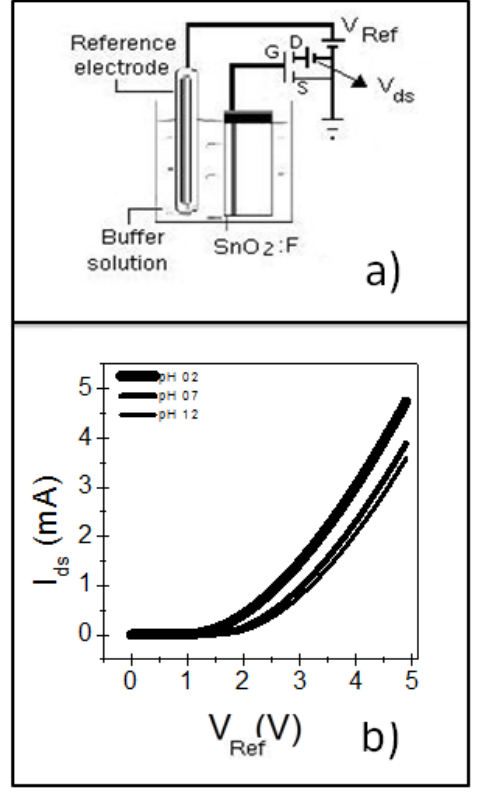
Fig. 1. (a) EGFET measurement system, and (b) typical I curve for different